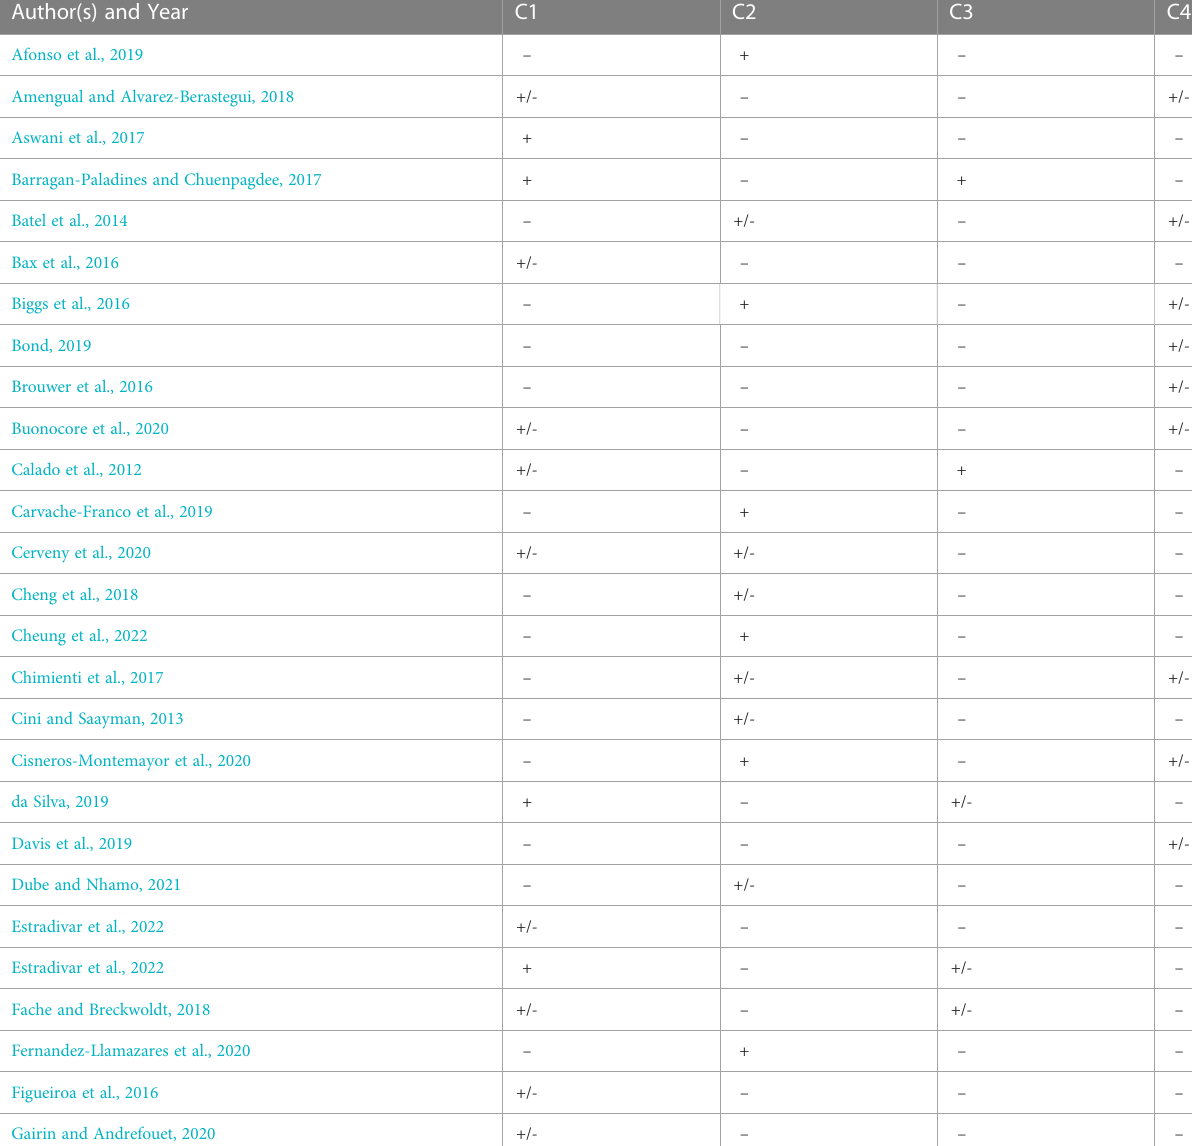
TABLE 1 Description of the literature sample based on the criteria (n=